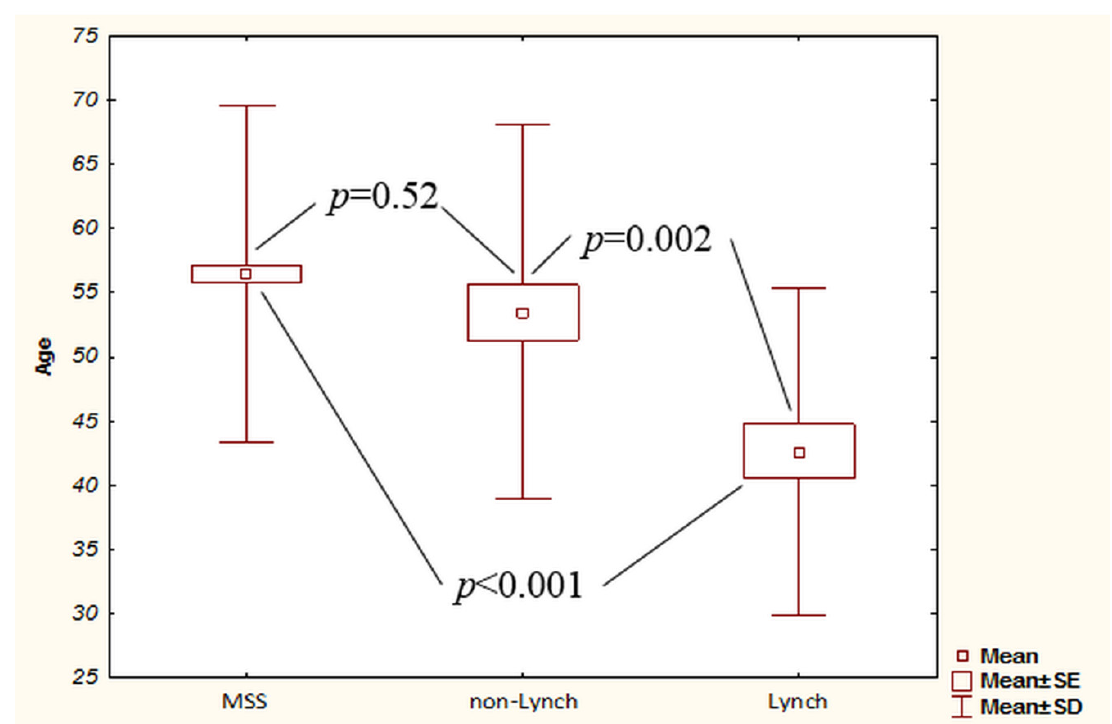
Figure 5. Age of patients whose tumors were MSS, MSI with Lynch’s syndrome, and MSI in sporadic cancer.